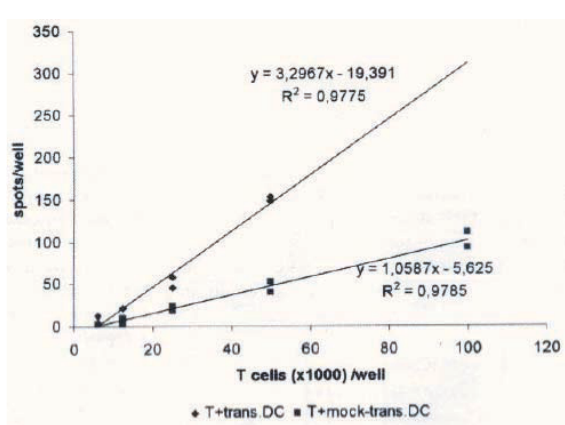
Figure 5. Autologous T cells stimulated with four times ex vivo irradiated transfected DC. ELISPOT assay indicates